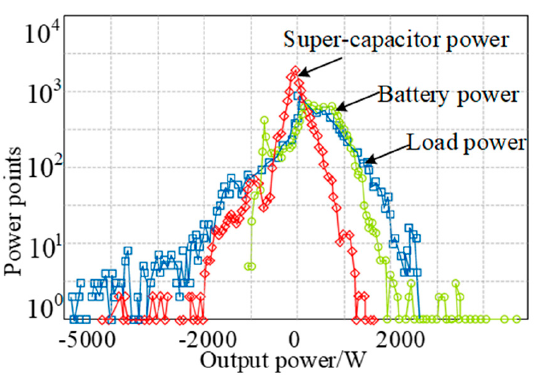
Figure 24. Super-capacitor power–voltage–current variation when accelerating.